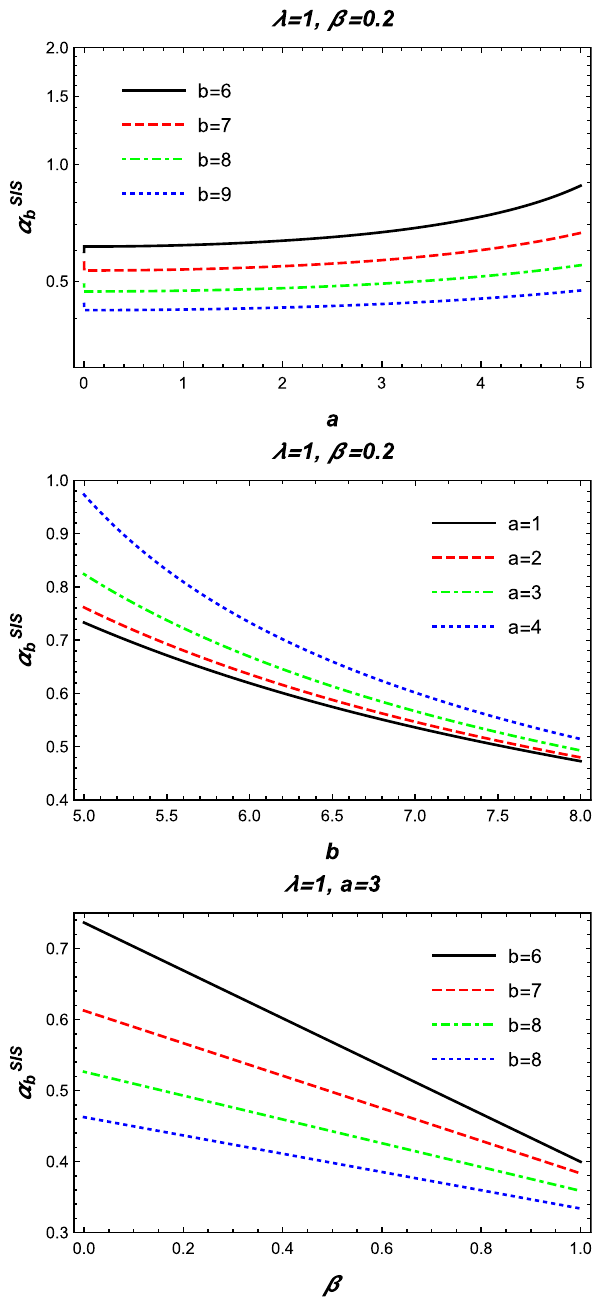
Fig. 15 α b for different value a , b and β in the singular isothermal sphere, λ = 1